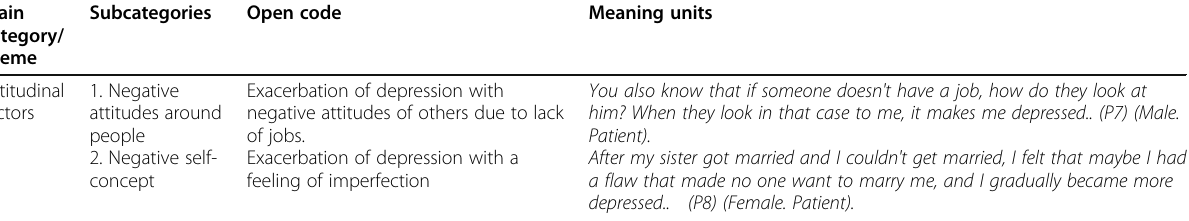
Table 1 A sample of the trend of condensation-abstraction process in this study Main category/